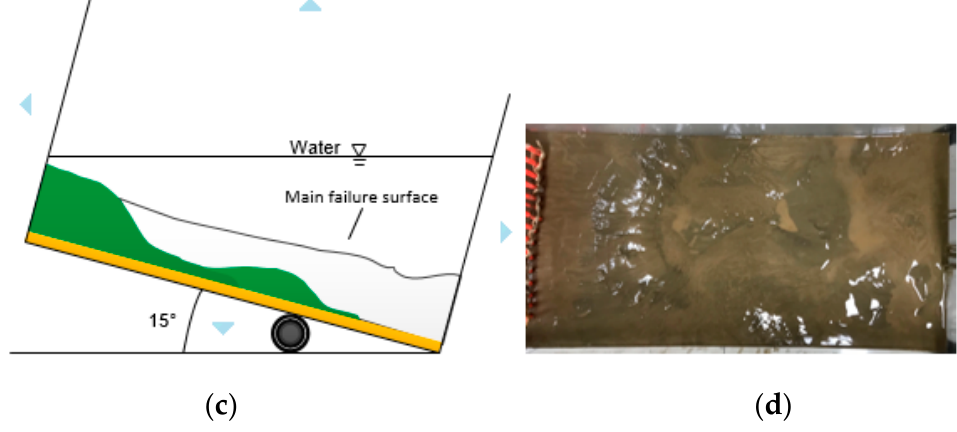
Figure 12. Profile and plan views of the slope after failure in Model 13-15. ( a ) Before Angle adjustment; ( b ) After the Angle adjustment; ( c ) After the destruction; ( d ) top view of end of experiment.